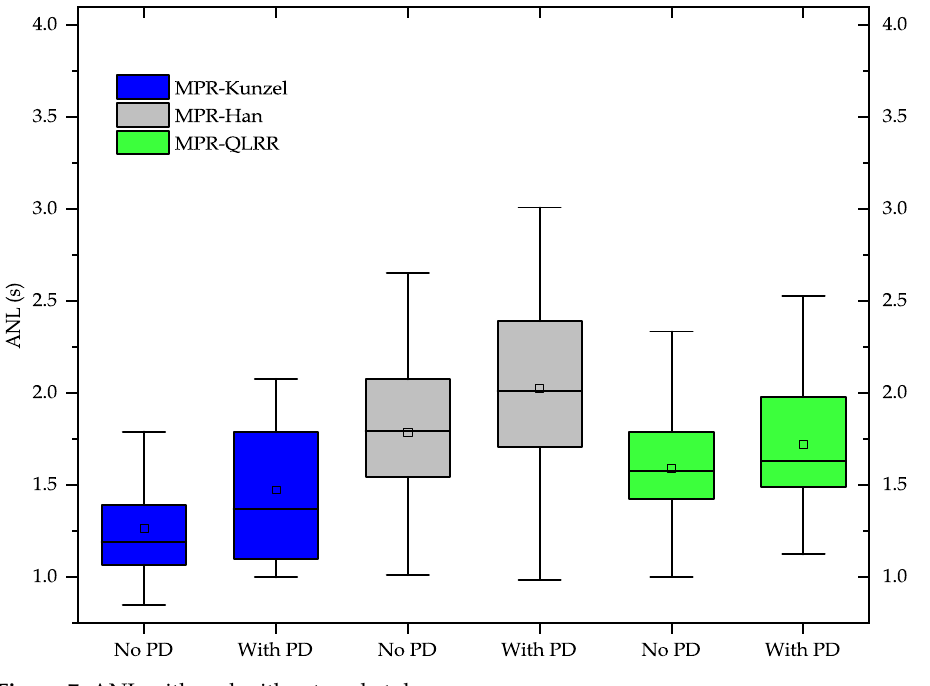
Figure 7. ANL with and without packet